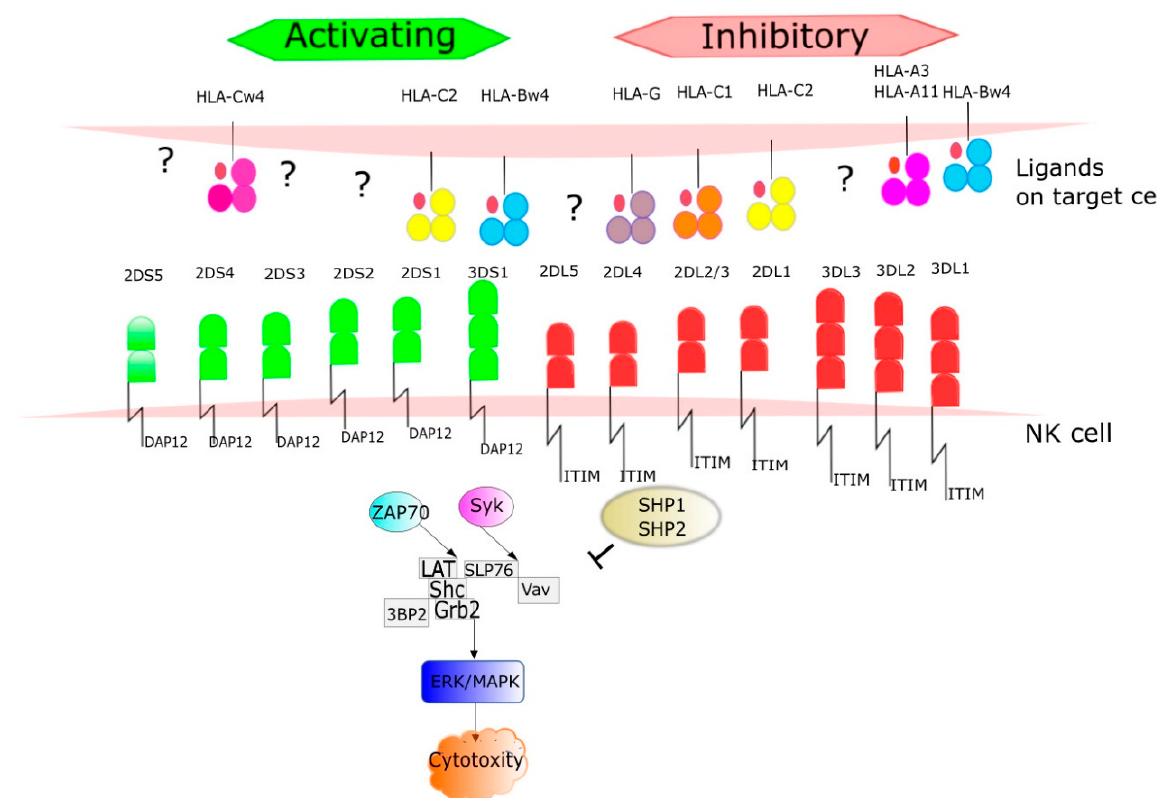
Figure 4. The ligands for KIR receptors are mainly HLA I antigens. HLA molecules were grouped into four major categories based on the amino acid sequence determining the KIR-binding epitope. All expressed HLA-C alleles are placed in C1 or C2 group and most HLA-B alleles can be classified as either Bw4 or Bw6. The number of protein sequence variants characterized to date for each KIR receptor is provided. The figure shows signaling pathways from the activated receptors via tyrosine kinase binding protein-DAP12 and inhibitory receptors to. Phosphorylation DAP12 events result in recruitment of SYK family kinases such as Syk (spleen tyrosine kinase) and ZAP70 (zeta-chain associated protein kinase 70 kDa). In this pathway take part via alia LAT (Linker for activating of T cells), Shc (Src homology 2 domain containing), GRB2 (Growth factor receptor-bound protein 2), 3BP2(c-Abl Src homology 3 domain-binding protein -2). Syk interacts with SLP76 (SLP-76 tyrosine phosphoprotein) and activates Vav proteins (guanine nucleotide exchange factors). ZAP70 and SYK pathways lead to ERK (extracellular signal-regulated kinases) and MAPK (mitogen-activated protein kinases) activation results in NK cells cytotoxity. Once the ligand is recognized by an inhibitory receptor, the pathway is blocked through dephosphorylation by tyrosine phosphatase protein (SHP-1) and 11 (SHP-2).